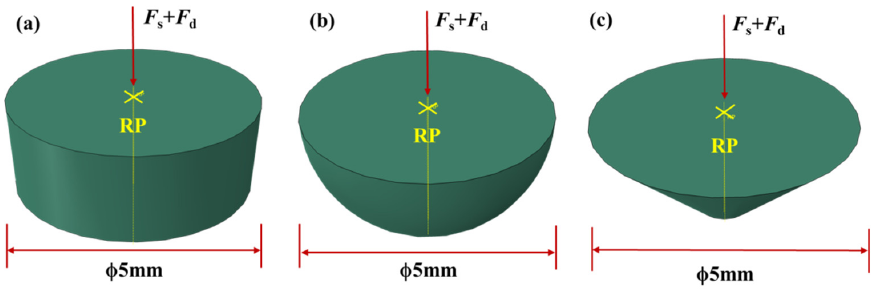
Figure 13. 3D finite element models of indenters: ( a ) cylinder; ( b ) sphere; ( c ) cone. RP, Fs and Fd represent the reference point, static and dynamic load, respectively.